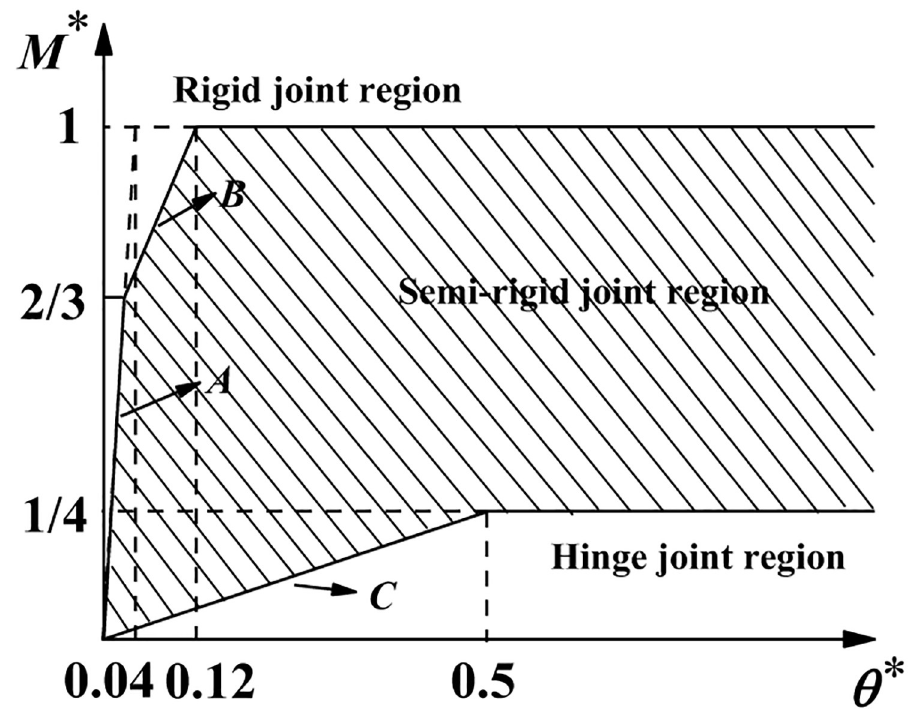
Fig 9. Semi-rigid judgment criteria for socket-type